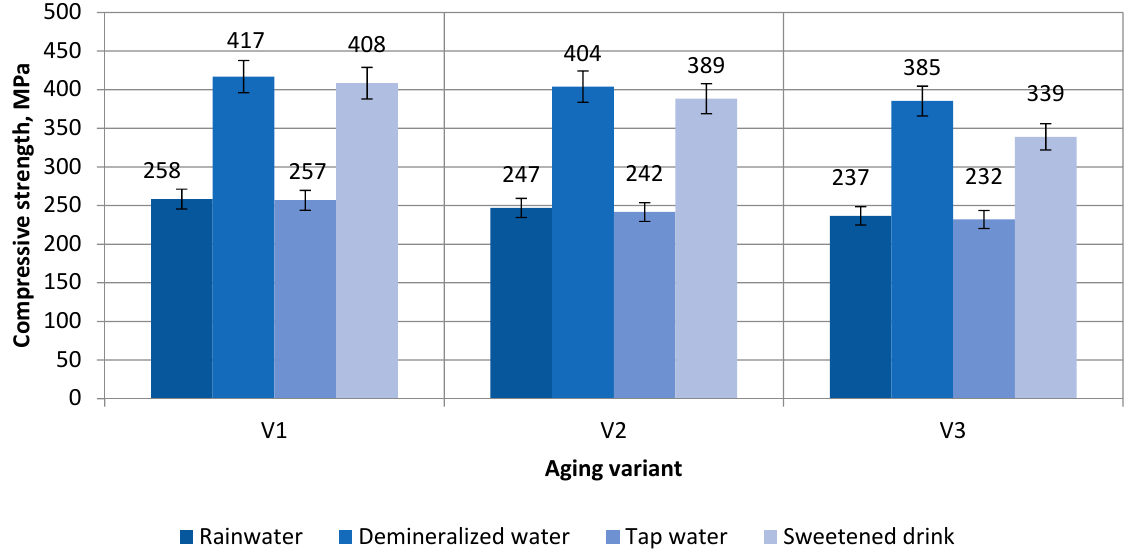
Figure 5. Compressive strength of Epidian 57/Z-1/10:1 epoxy compound samples aging in various aqueous environments.